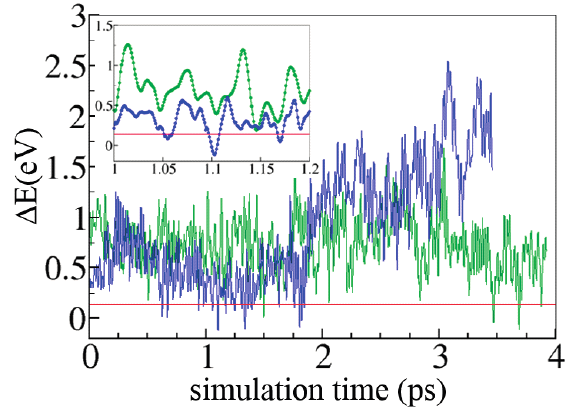
Figure 13. Evolution of the diabatic energy gap along two cDFT/MM MD trajectories carried out on the PES of state CT1. The horizontal red line indicates the value of the average electronic coupling obtained along the two